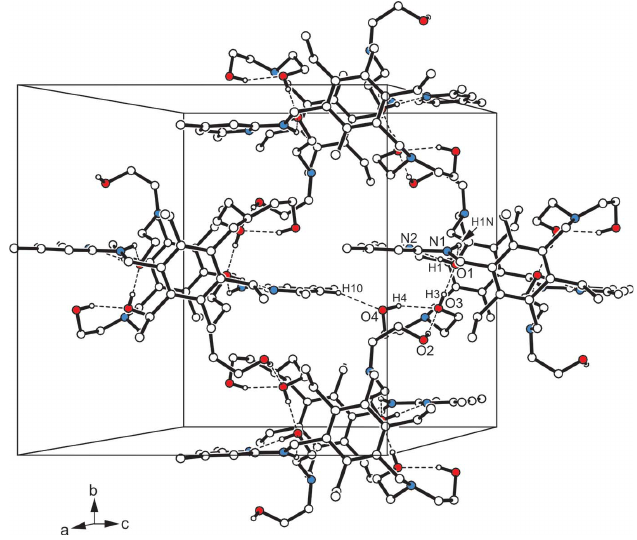
Figure 1 Perspective view of the molecular structure of the title compound including atom numbering. Anisotropic displacement ellipsoids are drawn at a 50% probability level. Dashed lines represent hydrogen- bonding interactions. For the sake of clarity, only the major position of the disordered bis(hydroxyethyl)amino moiety is shown.